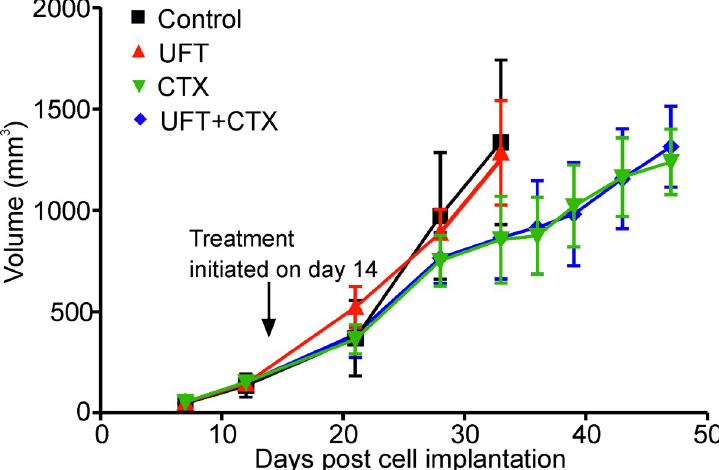
Fig 1. Effect of UFT, CTX and UFT+CTX metronomic chemotherapy on localized primary tumors. 231/LM2-4 human breast metastatic variant cells were orthotopically injected into the right inguinal mammary fat pad of 6–8 week-old female SCID mice. When tumors reached volumes of ~160–190 mm 3 , treatment with vehicle control 0.1% HPMC orally daily (black), 15 mg/Kg/d UFT by gavage (red), 20 mg/Kg/d CTX through the drinking water (green) or the combination UFT+CTX treatment (blue) was initiated. Primary tumors were surgically removed when they reached an average size of approximately 1,300 mm 3 .